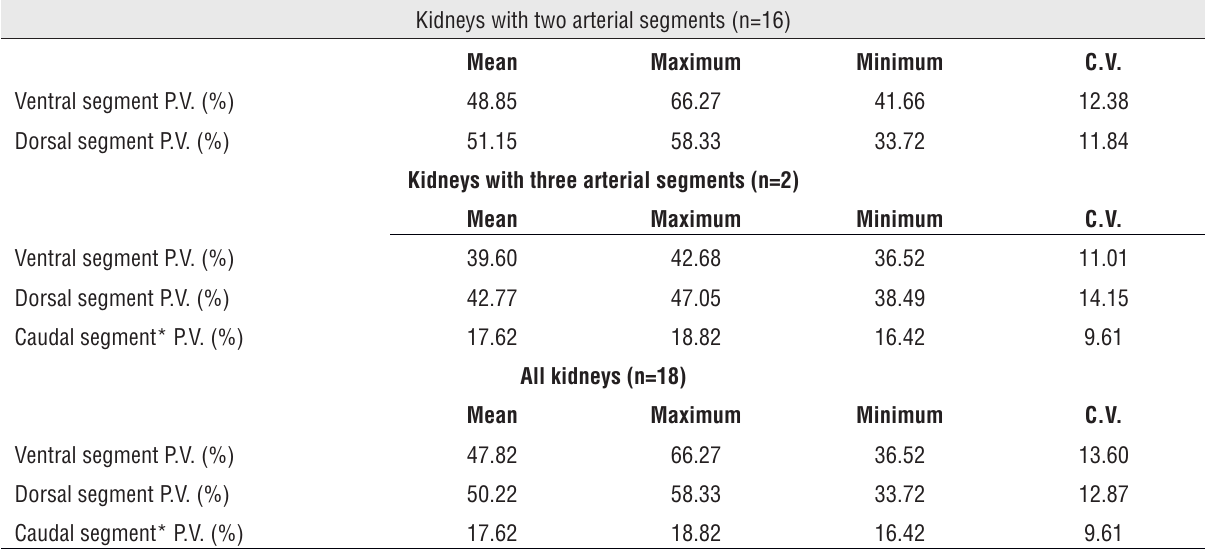
Table 1 - Proportional and absolute volumes of renal segments and renal volume of ovine